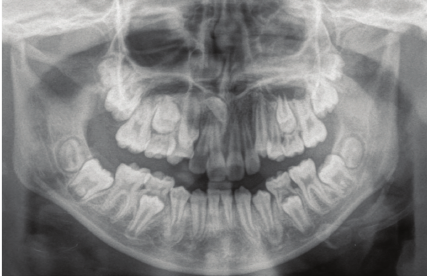
Figure 2: Lower occlusal photograph of dentition showing clinical absent lower lateral incisors.